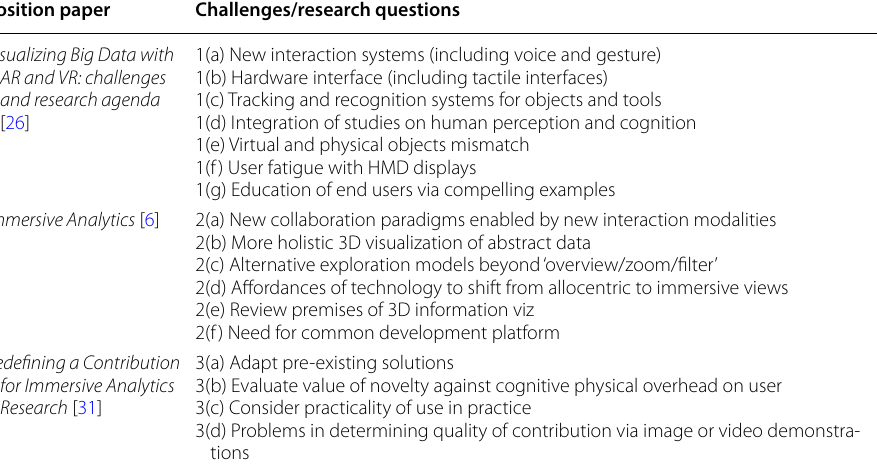
Table 1 Summary of challenges and research questions for immersive analytics within the position papers of Olshannikova et al. [26], Chandler et al. [6] and Sadana et